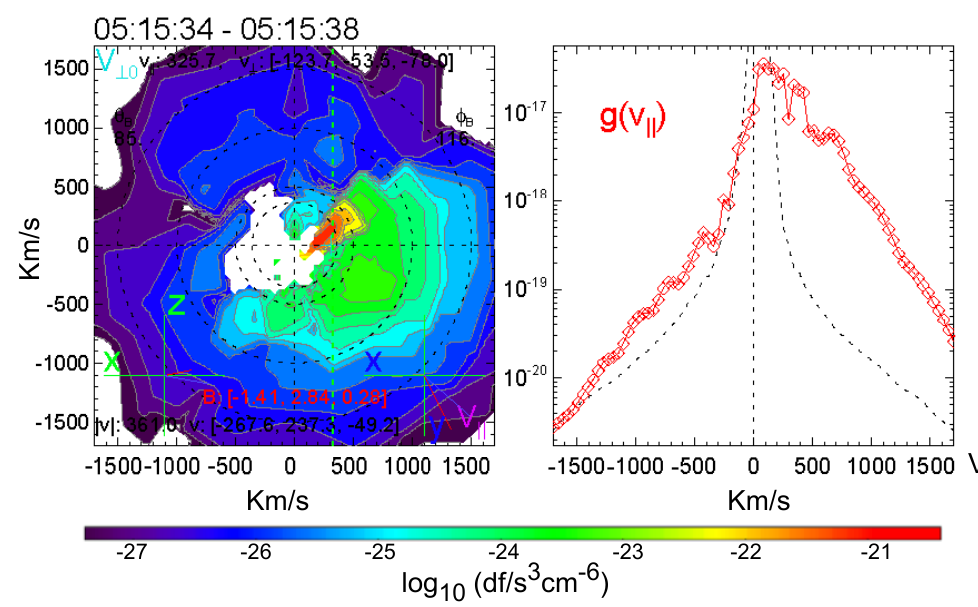
Fig. 6. The ion distribution during the interval A3. Left: a ( v || , v ⊥ ) slice through velocity space. Right: reduced distribution (a one-D cut along v || at v ⊥ =0). The dotted curves are instrument one-count